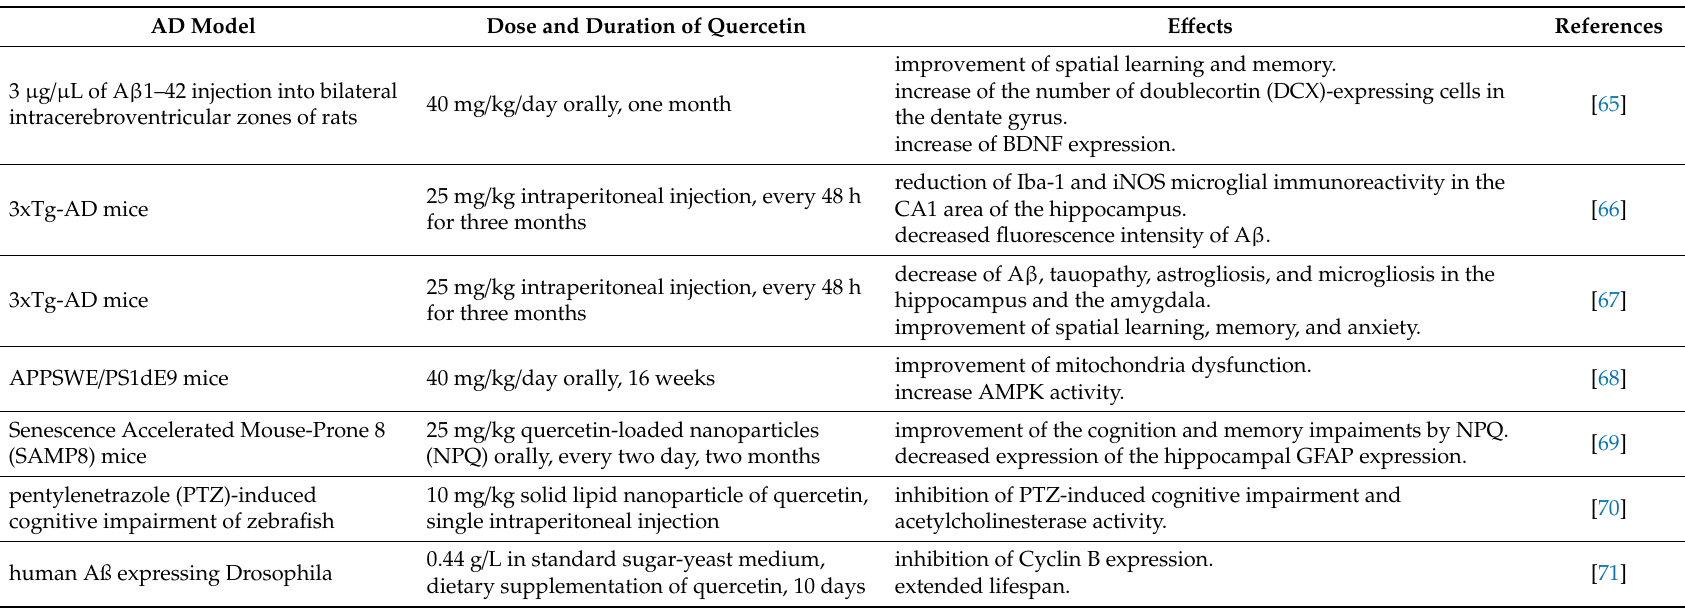
Table 1. Alzheimer’s disease (AD) model and e ff ects of quercetin on